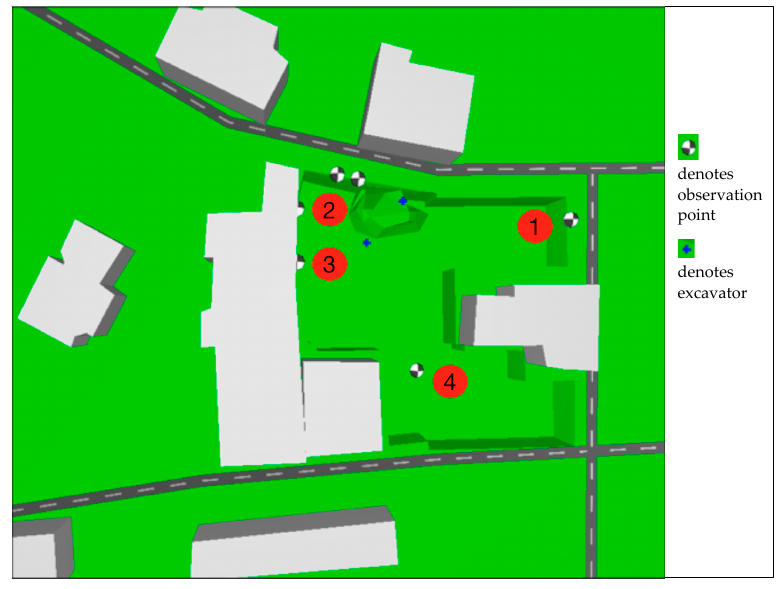
Figure 2. Locations of the observation points and adjacent buildings.